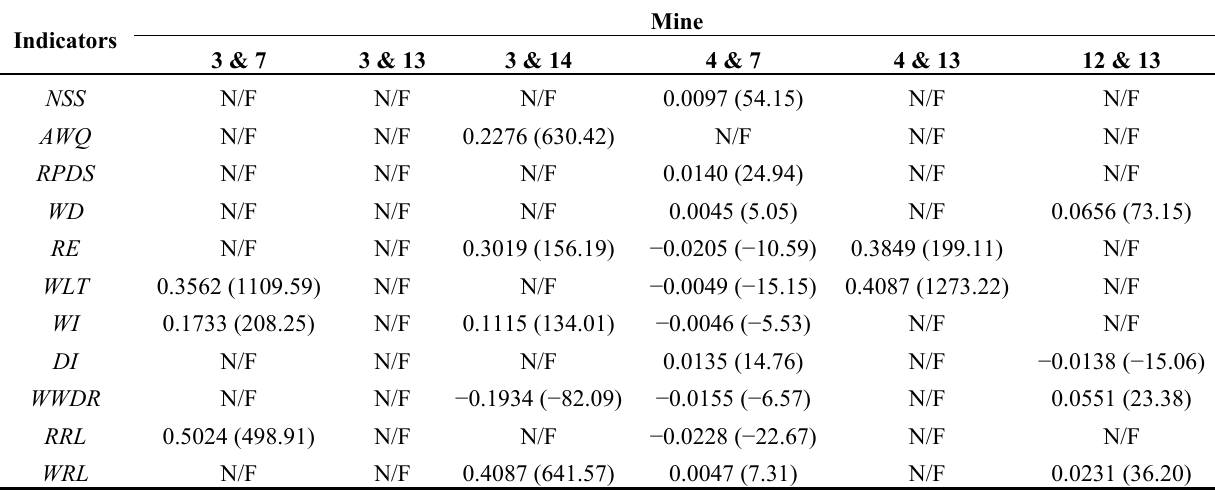
Table 5. The minimum weight change (